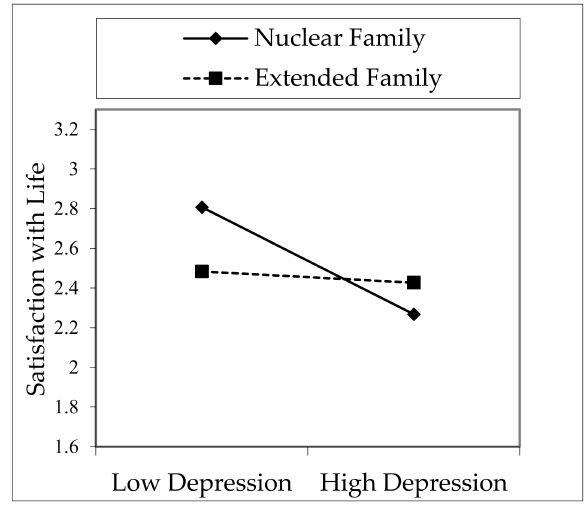
Figure 3. Interaction effect of family type and depression on satisfaction with life.